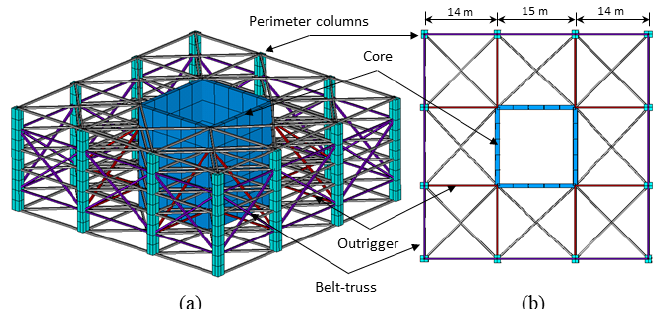
Figure 2. Numerical model in (a) perspective (b) plan.